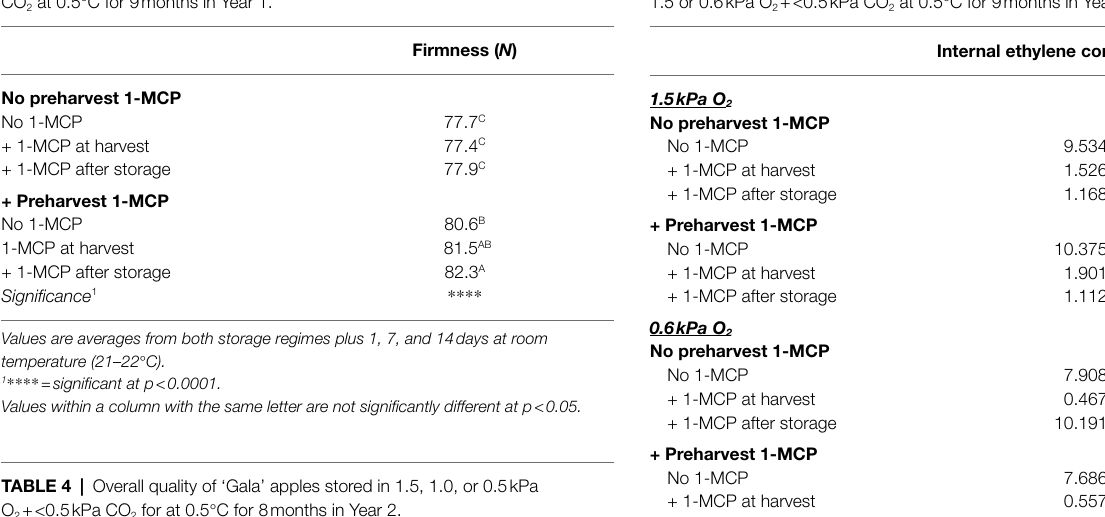
TABLE 3 | Firmness of ‘Gala’ apples treated without or with preharvest 1-MCP orchard spray at 7 days before harvest in combination without or with postharvest 1-MCP (1 μ l L -1 ) for 24 h at harvest or after storage in 1.5 or 0.6 kPa O 2 + <0.5 kPa CO